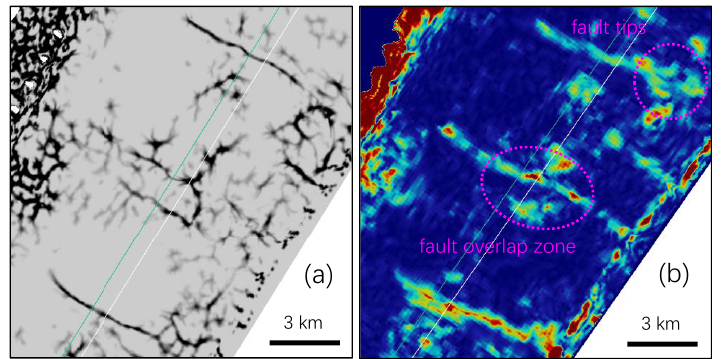
Figure 7. ( a ) Seismic coherence plane attribute and ( b ) processed by steerable pyramid in the study area.